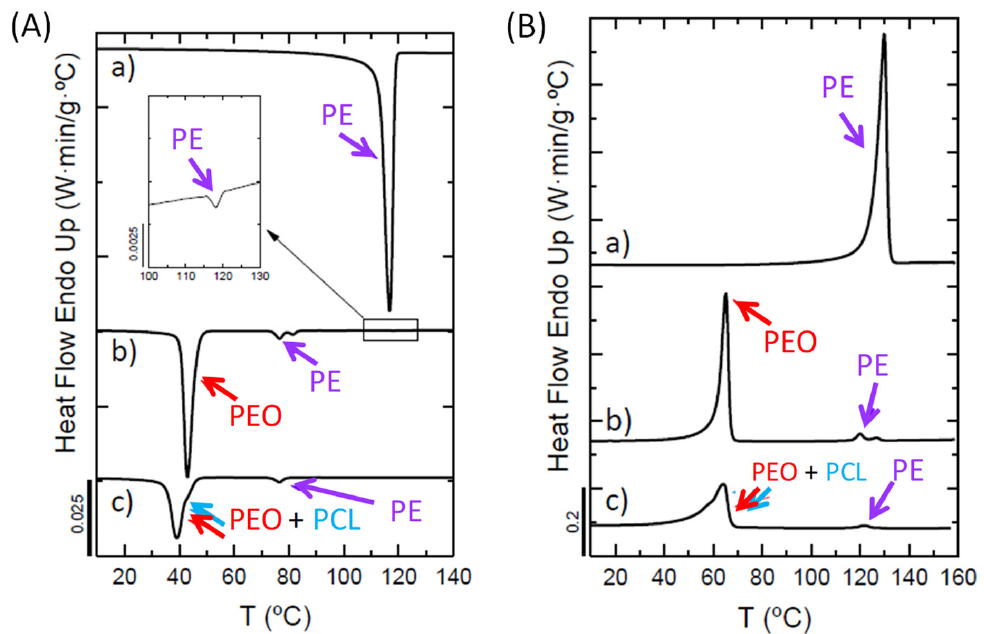
Figure 3. DSC scans at 20 ◦ C/min for (a) PE 7.1 , (b) PE 327.1 - b -PEO 6815.1 , and (c) PE 227.1 - b -PEO 4615.1 - b -PCL 3210.4 (T1) of ( A ) cooling from the melt, with a close-up to notice the very first crystallization exotherm of the PE block and ( B ) subsequent heating with arrows indicating transitions for each block .